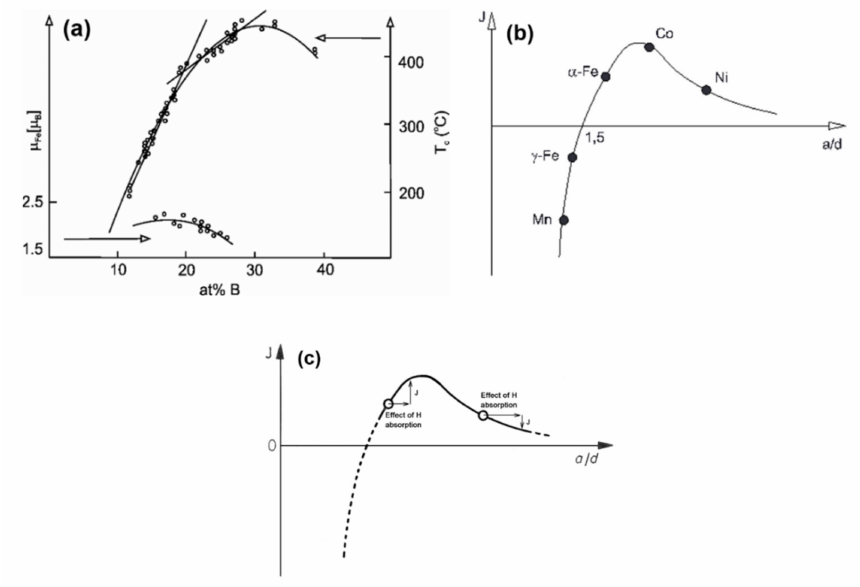
Figure 6. ( a ) Concentration dependence of the Curie temperature ( T Cam ) and the magnetic moment ( µ Fe) in glassy Fe-B alloys (adopted from [59], with permission from Trans Tech Publications, 1982). ( b ) Bethe–Slater curve representing the variation of the exchange integral J with interatomic spacing a and radius d of the unfilled d shell (adopted from [60], with permission from IOP publishing, 2009); ( c ) Bethe–Slater curve representing the variation of the exchange integral J with interatomic spacing a and radius d of the unfilled d shell (adopted from [60], with permission from IOP publishing,